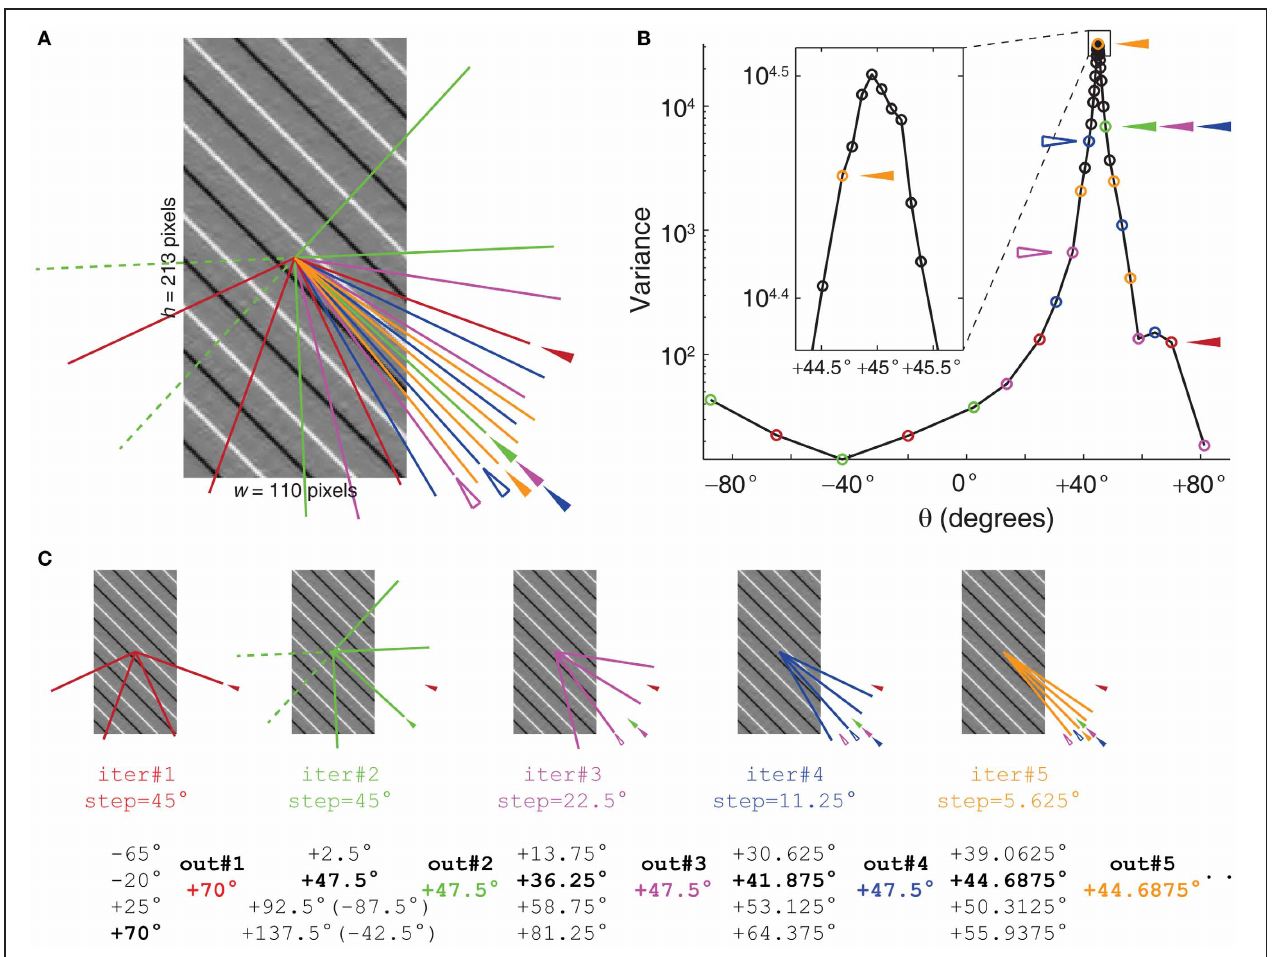
FIGURE 7 | Iterative Radon transform with progressively finer angle steps on subsequent iterations leads to precise angle measurements. (A) An image with 45 ◦ stripes after Sobel filtering. Color-matched lines represent angles of the first five Radon transform iterations. Additional iterations continue with step-size and angular span values that are half of the preceding iteration. (B) Radon variance plot, showing the variance of the Radon transform at 40 different angles corresponding to 10 iterations. The final angle step-size ( δ ) was approximately 0.0879 ◦ (Equation 19), sufficient to detect ∼ 0.3% fractional change in the velocity ( (cid:2) v / v ) for this particular streak angle (45 ◦ , Equation 16). The variance values are represented with open circles and the first five iterations are color-matched with the lines shown in (A) . Filled arrowheads of the corresponding colors in (A) and (B) represent the angle values for given iterations that were carried forward to the next